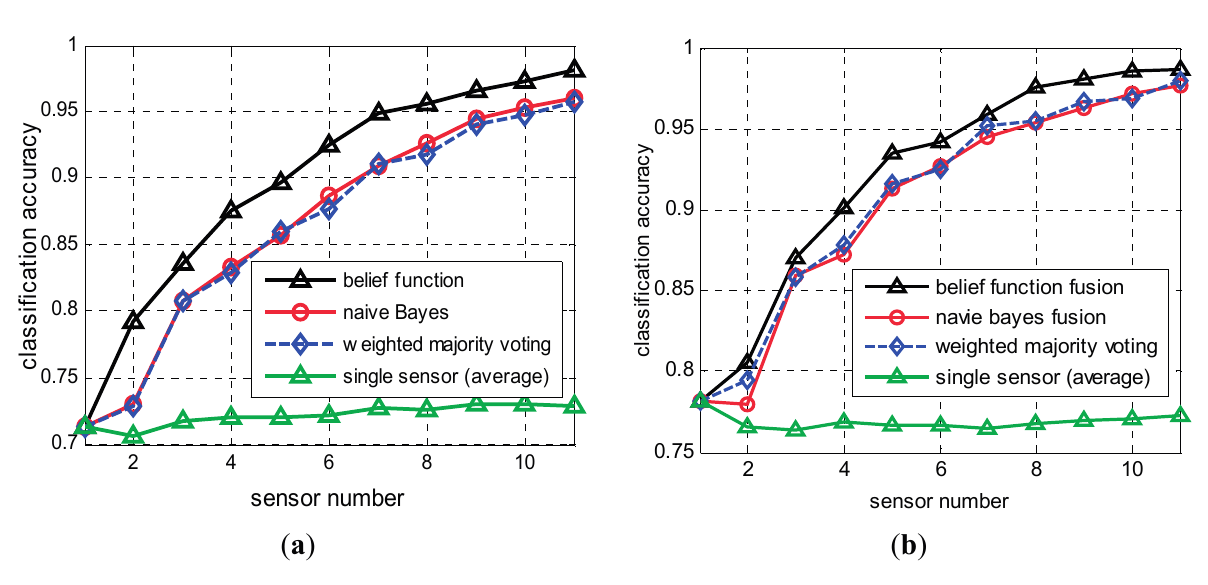
Figure 7. Classification accuracy as a function of sensor numbers. Classifiers used in subplots ( a , b ) are k -NN and ELM neural network,